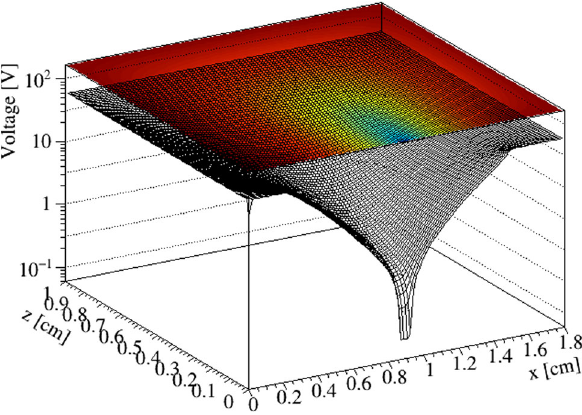
Fig. 11 The potential field distribution in the detector when a positive voltage of 60 V was applied to the outside surface contact.The absence of any white area indicates that the detector is fully depleted